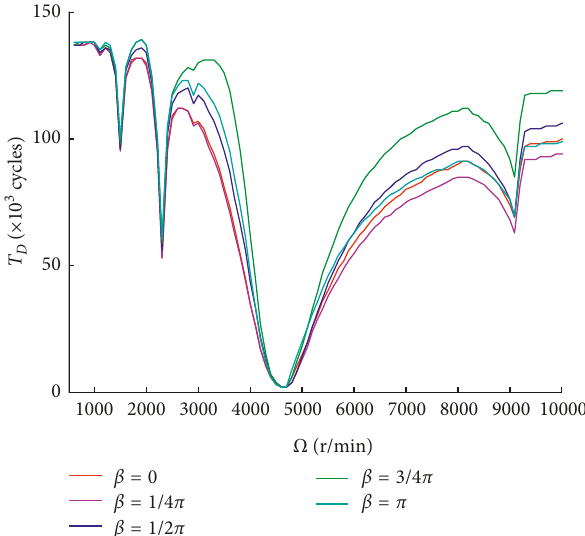
Figure 15: Average degradation rate versus unbalance orientation angle for different rotation speeds with r � 0 . 4, ε � 1 × 10 − 5 m, and ζ �